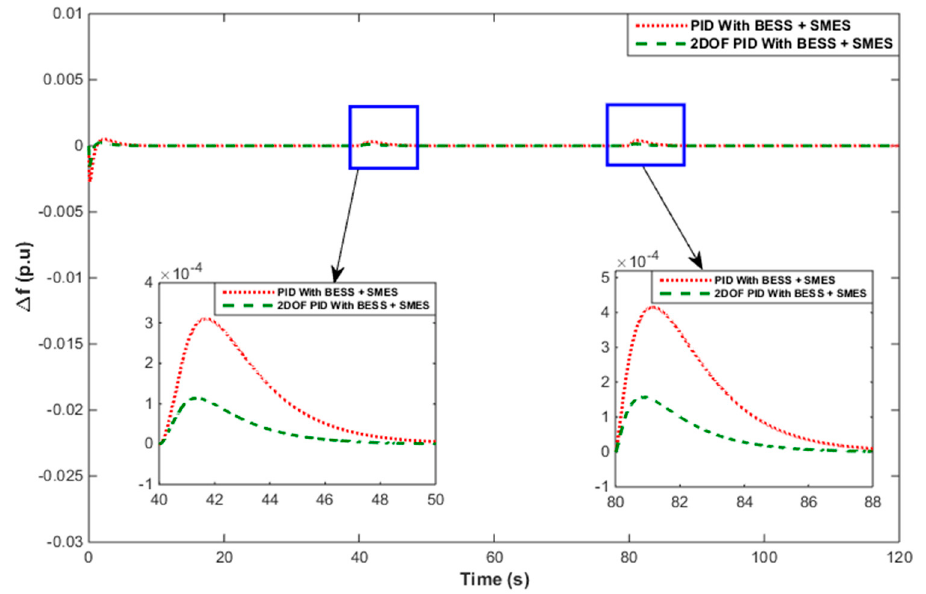
Figure 20. Comparative performances of the frequency responses of BESS + UC (case 2) and BESS + SMES (case 3) with the FPA-optimized PID- and 2DOF-PID-controller-based hybrid power networks.